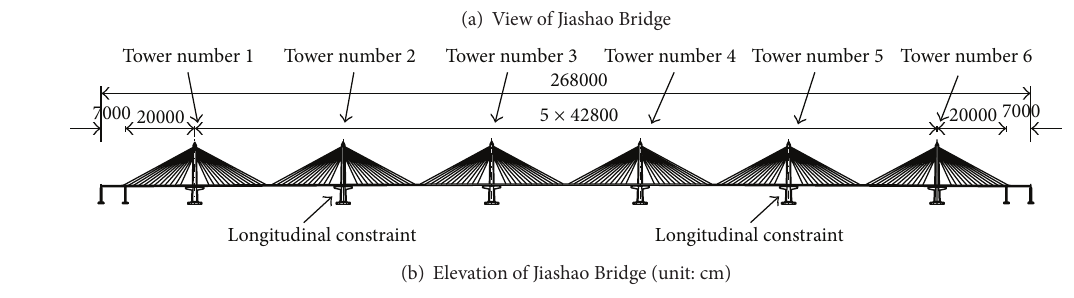
Figure 1: Jiashao